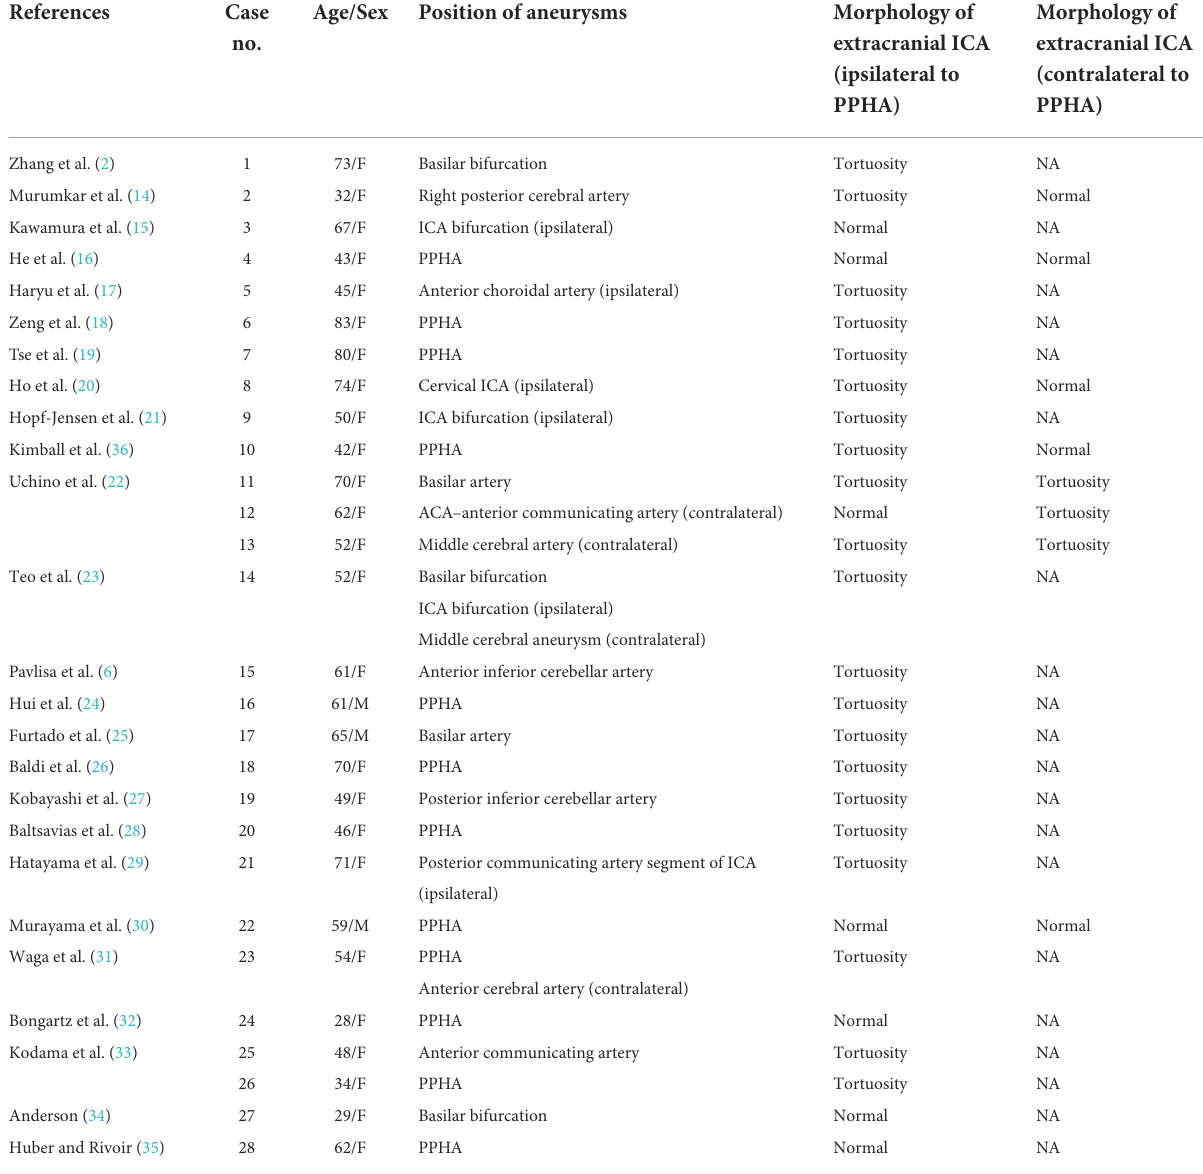
TABLE 1 Summary of 28 cases of persistent primitive hypoglossal artery (PPHA) and